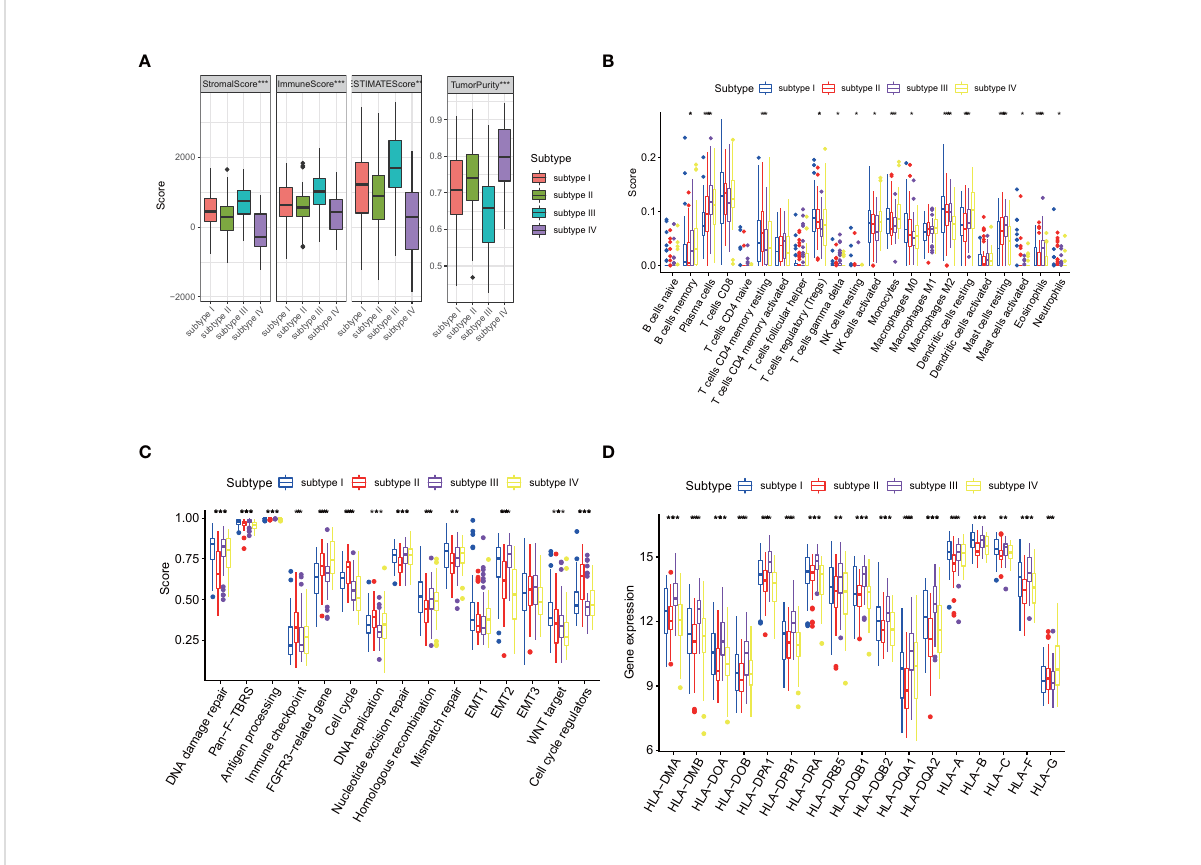
FIGURE 7 Comparison of four subtypes.(p values were showed as: * p < 0.05; ** p < 0.01; *** p < 0.001. **** p < 0.0001). (A) Differences in TME and tumor purity among four subtypes in GSE53625. (B) Differences in immune cells among four subtypes in GSE53625. (C) Differences in core biological pathways among four subtypes in GSE53625. (D) Differences in HLA gene expression among four subtypes in